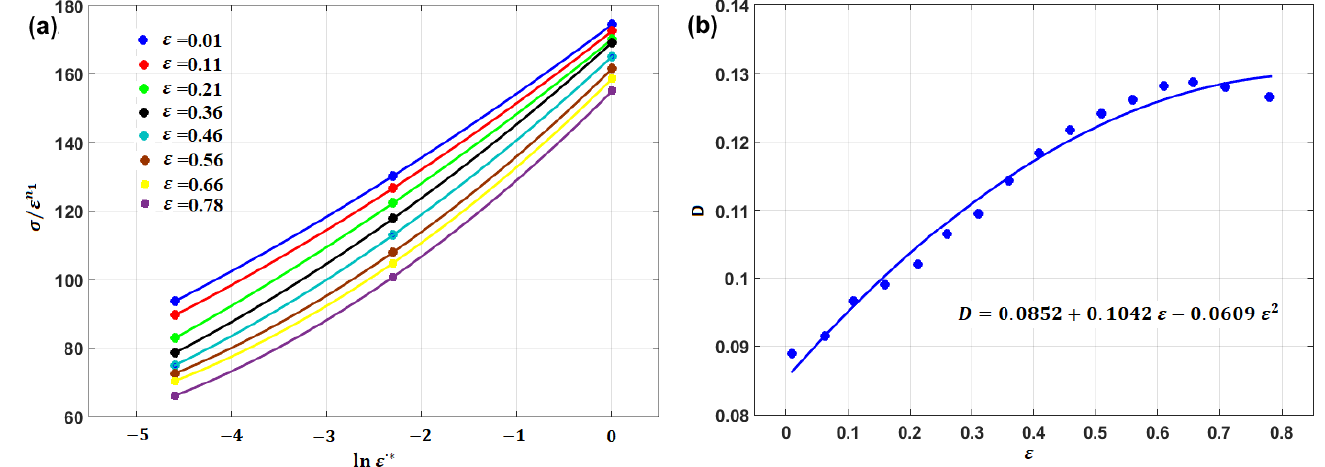
Figure 39. Determination of coefficients 𝑏 1 , 𝑏 2 , and 𝑏 3 : ( a ) determination of different values of 𝐷 at different 𝜀 values and ( b ) quadratic fitting between 𝐷 and 𝜀 .